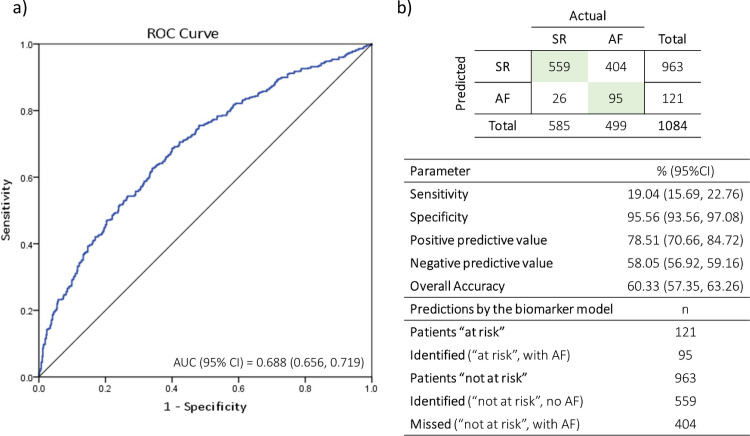
Model validation performance.(a) The AUC of the validated model (0.688; 95% CI 0.656, 0.719) closely approximated that of the derived model (0.691; 95% CI 0.638, 0.774). (b) The confusion matrix and performance metrics suggest that the model is highly sensitive in being able to identify sinus rhythm patients to “rule out” AF, and has an overall accuracy of 60%. AF, atrial fibrillation; AUC, area under the receiver operating characteristic curve; CI, confidence interval; ROC, receiver operating characteristic; SR, sinus rhythm.